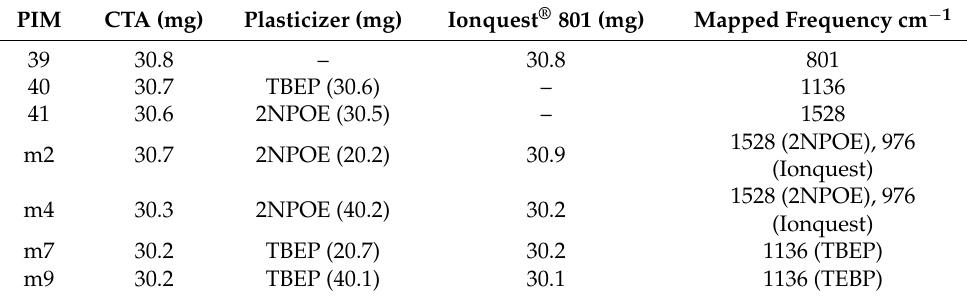
Table 6. PIM compositions for Reflection Infrared Mapping Microscopy